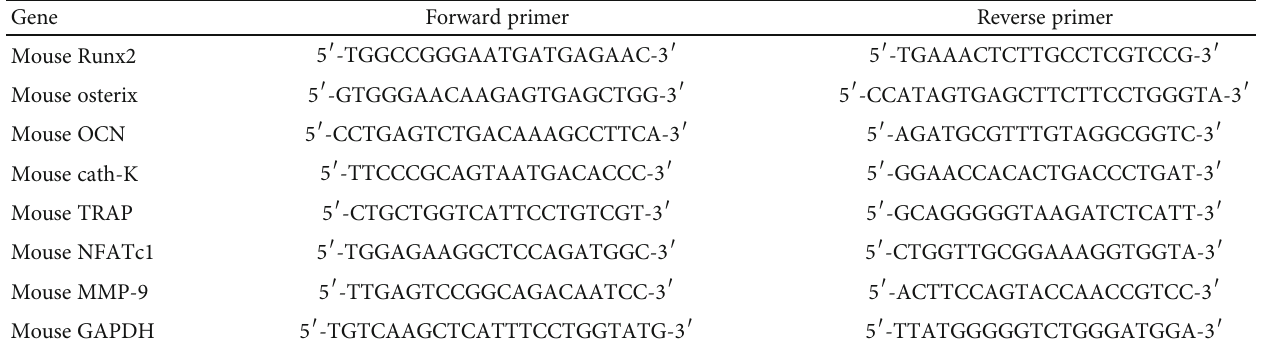
Table 1: Primer sequences of the